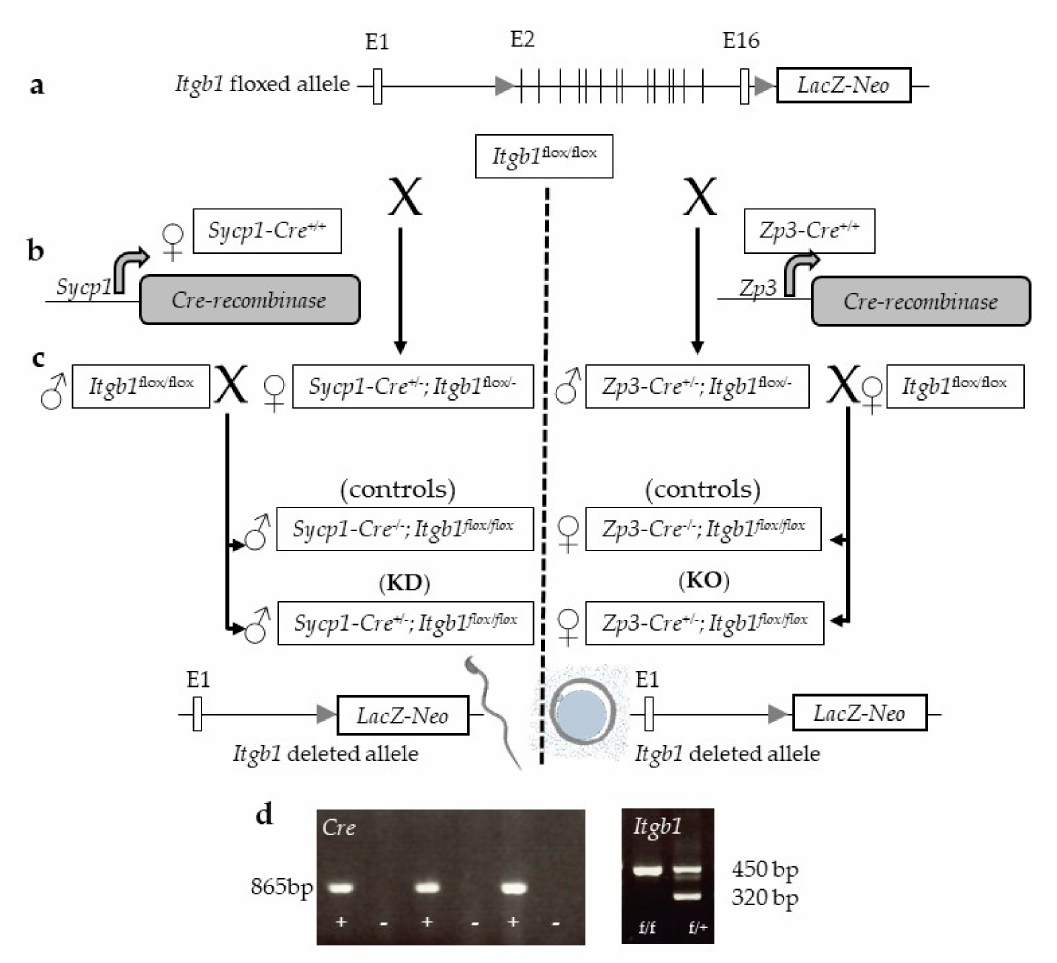
Figure 1. ( a ) Schematic representation of the Itgb1 floxed allele. To monitor Cre mediated deletion, a promoterless LacZ gene was inserted downstream of the 3 (cid:48) loxP site, resulting in LacZ expression driven by the endogenous Itgb1 promoter only after deletion; ( b ) First round mating using Itgb1 flox / flox with Sycp1-Cre +/+ females or Zp3-Cre +/+ males to obtain double heterozygous Sycp1-Cre +/ − Itgb1 flox / - or Zp3-Cre +/ − Itgb1 flox / − that ( c ) we mated, respectively, with Itgb1 flox / flox males or females. These crosses made it possible to obtain (left) the males of interest ( Sycp1-Cre +/ − Itgb1 flox / flo , KD) and their controls ( Cre − / − Itgb1 flox / flox ) and (right) the females of interest ( Zp3-Cre +/ − Itgb1 flox / flox , KO) and their controls ( Zp3-Cre − / − Itgb1 flox / flox ); ( d ) By way of example, the two gels show the presence of Cre whether it is under the control of the Zp3 promoter or that of Sycp1 promoter and the presence of the Lox sites on one or two alleles. +/ − Itgb1 flox / flox Western blot analyses of sperm from Sycp1-Cre mice (KD1 and KD2) demonstrated weak but not absent signals corresponding to β 1 integrin compared to the control sperm from Sycp1-Cre − / − Itgb1 flox / flox (CTRL1 and CTRL2, Figure 2e) while β -tubulin expression was comparable in all samples. This result indicated that the Cre recombinase was not totally e ff ective. We used ImageJ software to measure the intensity of the bands corresponding to β 1 integrin normalized by β -tubulin expression levels. The comparison revealed that the expression level of β 1 integrin in KD sperm represented 14.1 ± 10.8% of the WT level (Figure 2f, p =